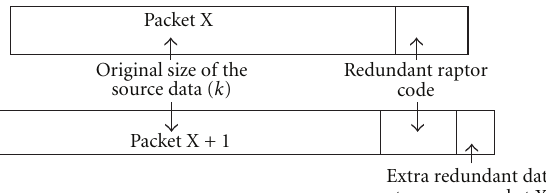
Figure 1: Division of payload data in a packet between source data, original redundant data, and extra redundant data for a previous erroneous